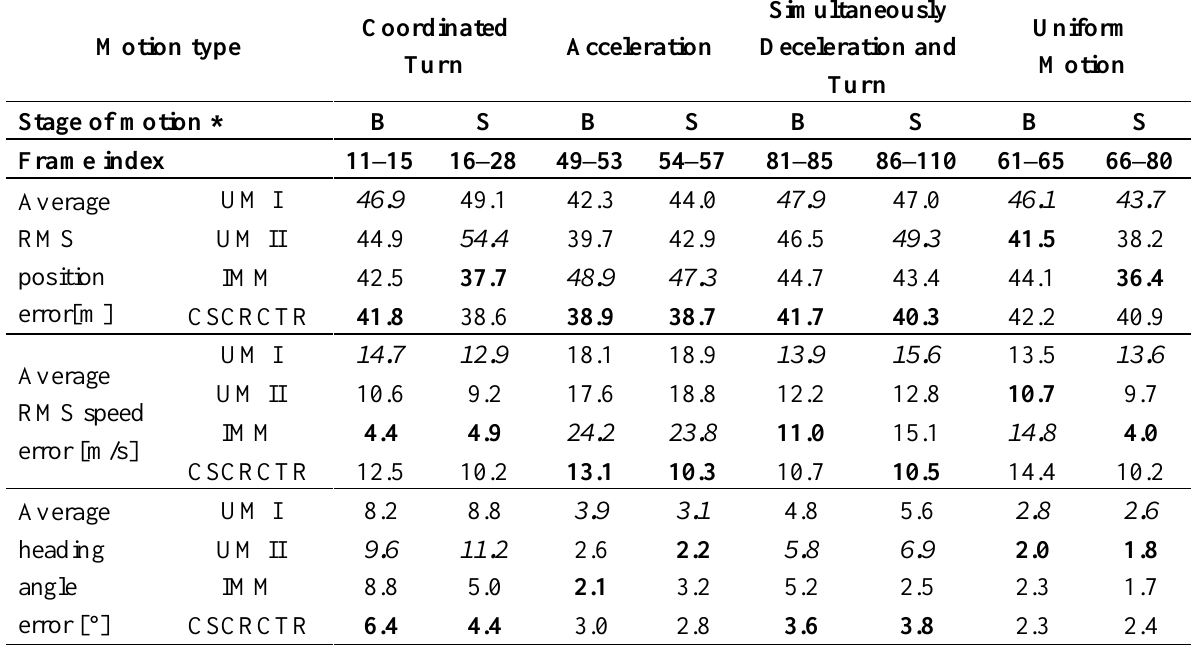
Table 2. Average tracking